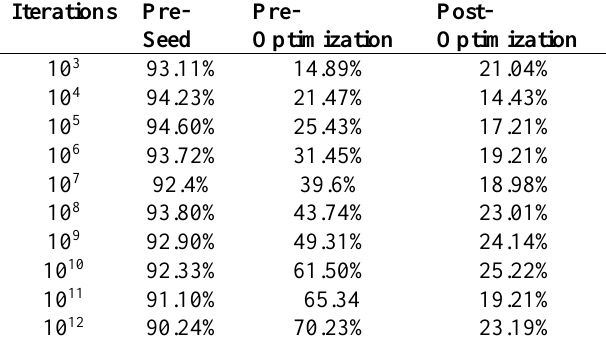
Table 1. Comparative analysis of tests under low and high noise